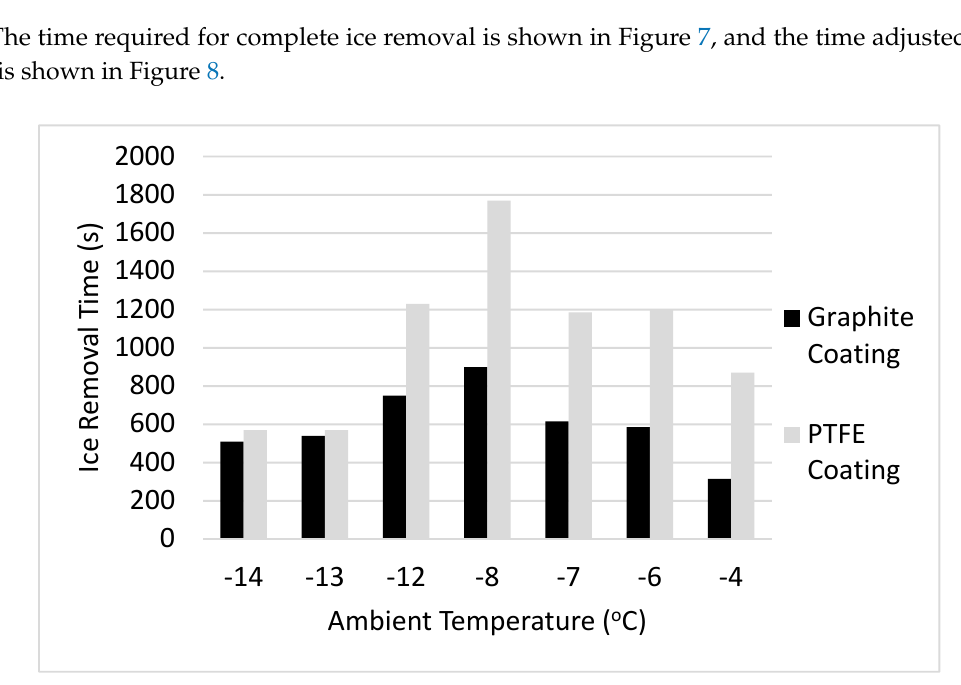
Figure 7. Ice removal time vs. test section temperature.